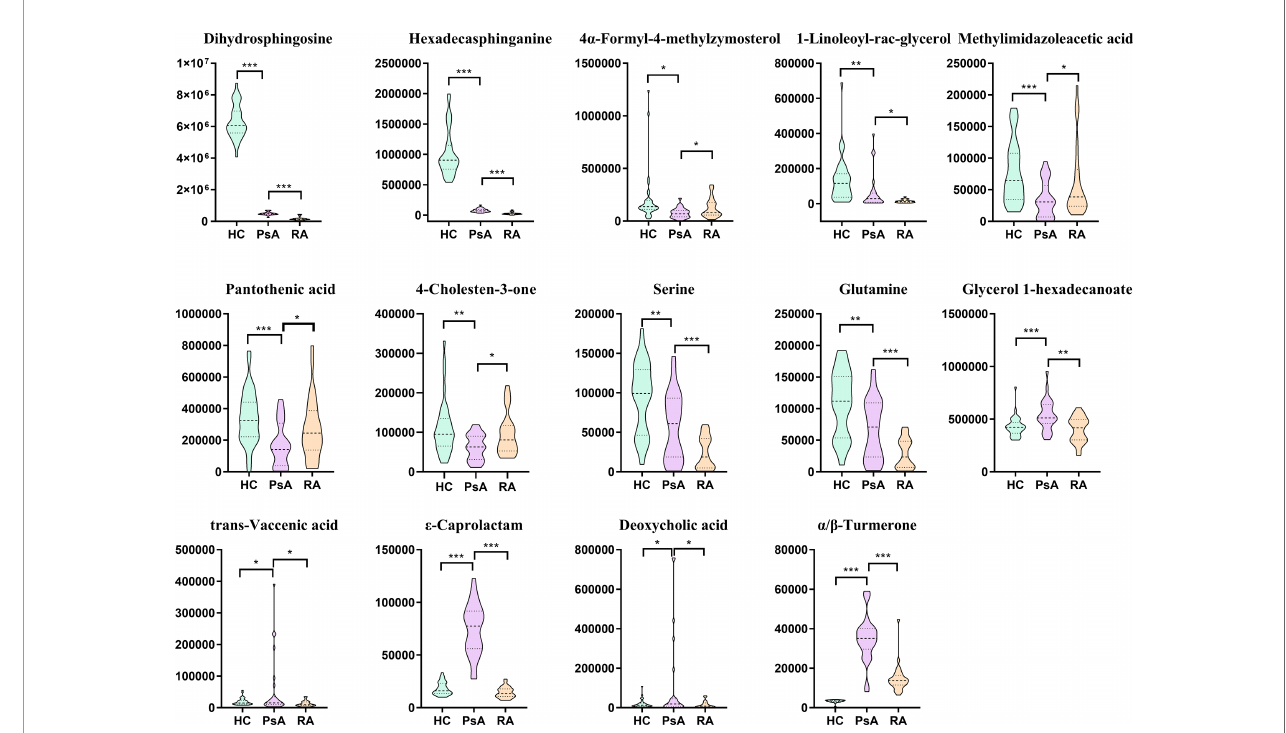
FIGURE 4 | Box plots of biomarker candidates. *, **, *** denoted p < 0.05, p < 0.01, and p < 0.001 in the PsA and other two groups comparison,